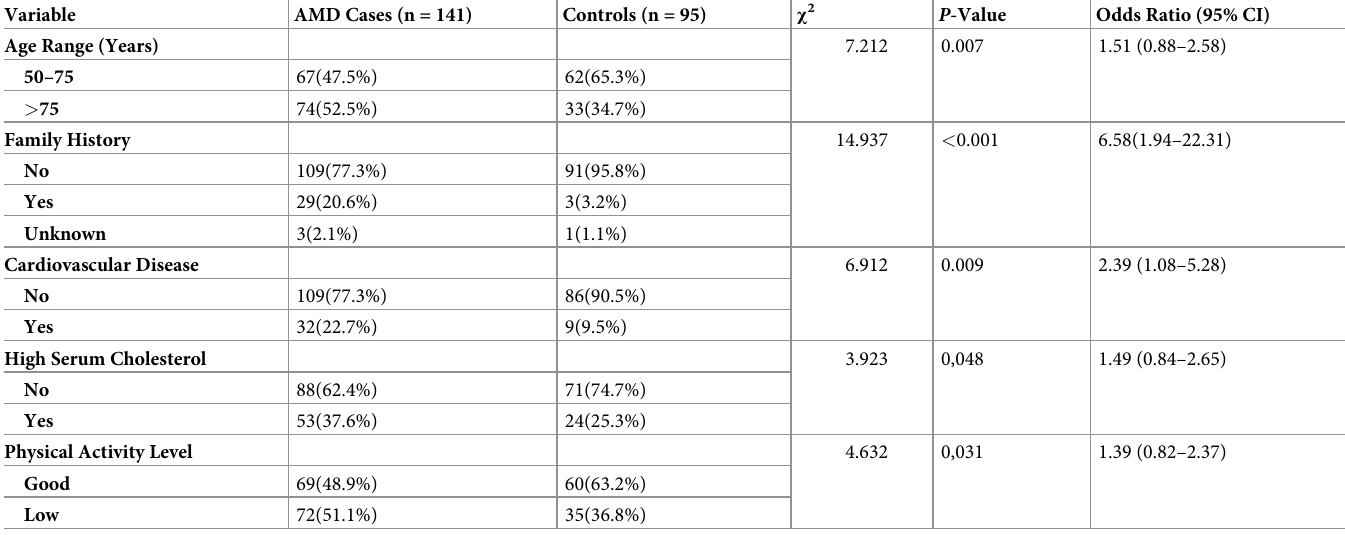
Table 1. Risk factors found to be significantly associated with AMD in a comparison between AMD patients and